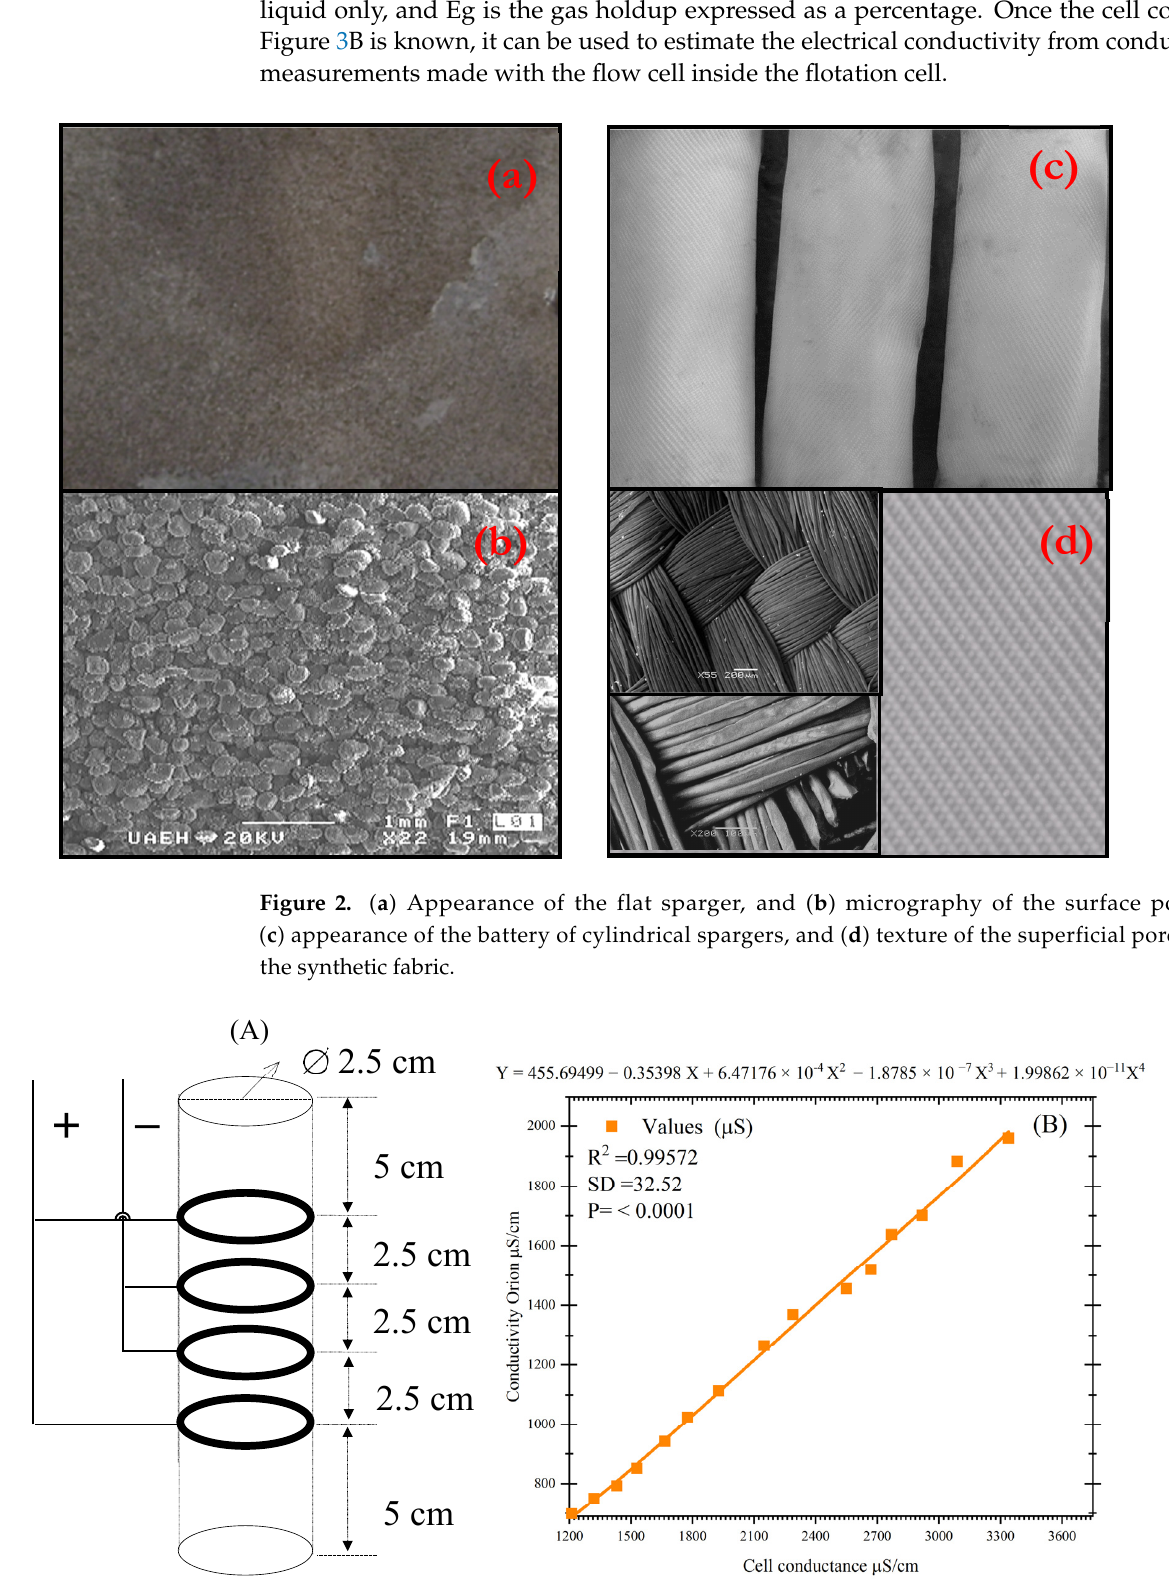
Figure 3. ( A ) Schematic representation of the conductivity flow cell with 1 cm thick graphite elec- trodes, and ( B ) electrical conductivity fl ow cell calibration curve.